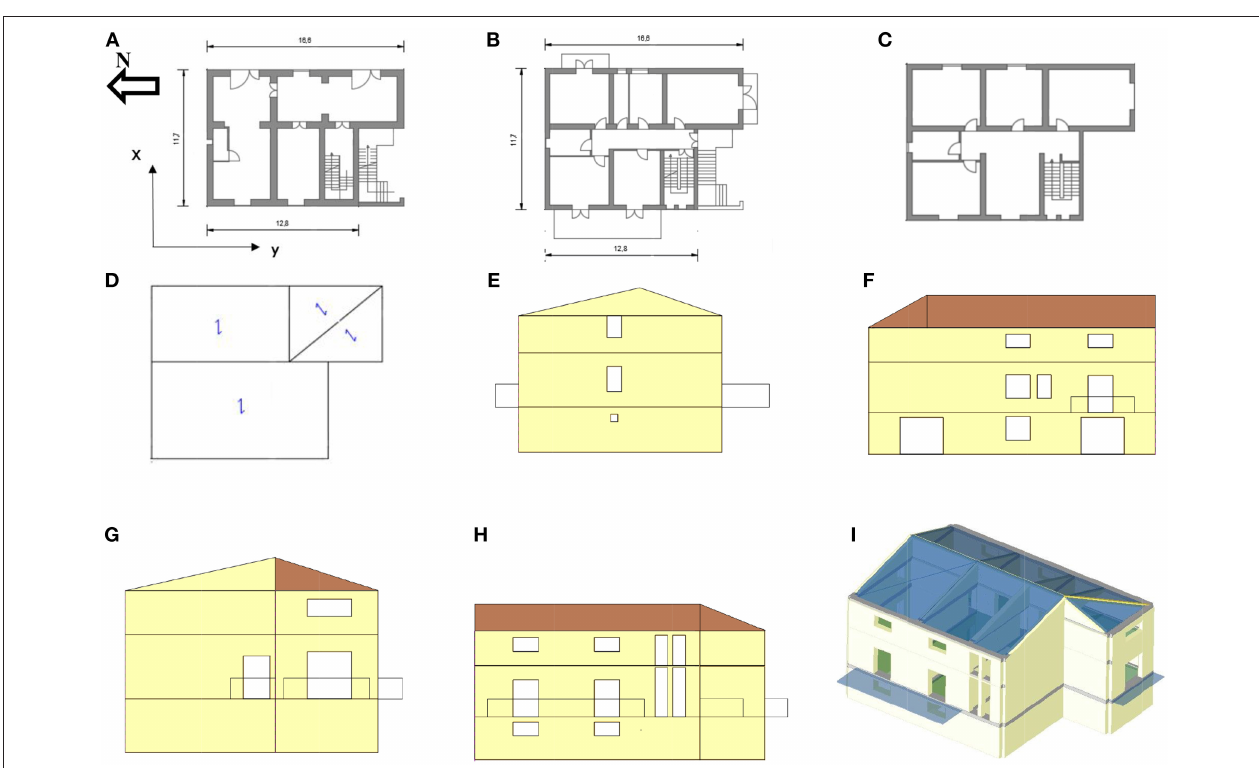
FIGURE 1 | Case study: First level (A) , second level (B) , third level (C) , roof (D) , north view (E) , east view (F) , south view (G) , west view (H) , and 3Muri model (I) .